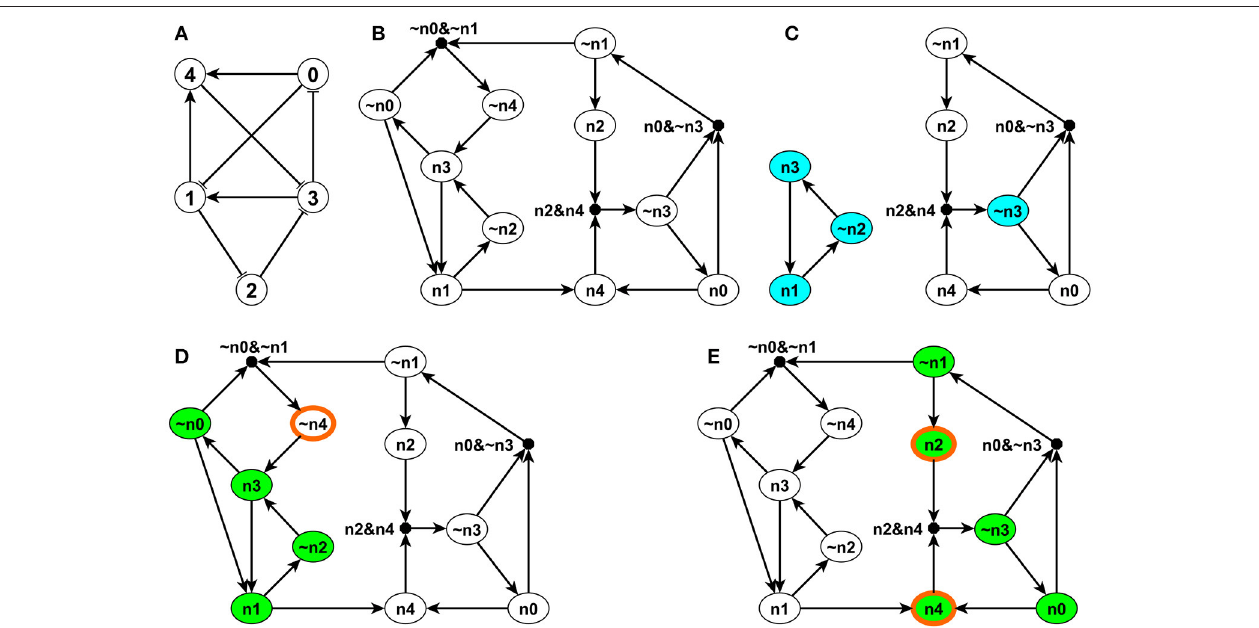
FIGURE 1 | Illustration of the expanded network, stable motifs and logic domain of influence on a simple example. The network is shown in panel (A) . Each edge with an arrow represents activation and each edge with a flat bar represents inhibition. The Boolean regulatory functions are specified as follows: f 0 = NOT σ 3 , f 1 = (NOT σ 0 ) OR σ 3 , f 2 = NOT σ 1 , f 3 = (NOT σ 2 ) OR (NOT σ 4 ), f 4 = σ 0 OR σ 1 . Panel (B) shows the expanded network of this example. Each node i in panel (A) has a correspondent n i and its complementary node ∼ n i in panel (B) . (Note that n i is labeled as ni in panel (B) to be more visible). A composite node is drawn as a filled black circle and & represents the AND logic operator. Panel (C) indicates the stable motifs; each blue node is a single-node core of the corresponding stable motif. Panels (D,E) show the LDOI of {∼ n 4 } and { n 2 , n 4 } , respectively, overlaid over the expanded network. Nodes with thick orange boundary are the sustained interventions and the green nodes are their